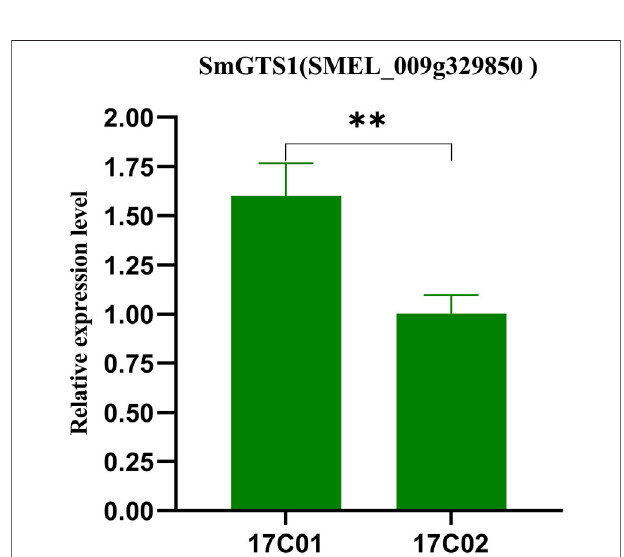
FIGURE 4 | Gene expression levels of the SmGTS1 in the parents (17c01 and 17c02). Expression of SmGTS1 in the seeds of the 17c01 and 17c02. Values are themean ±SD of three biological replicates. **: signi fi cantly different at p <